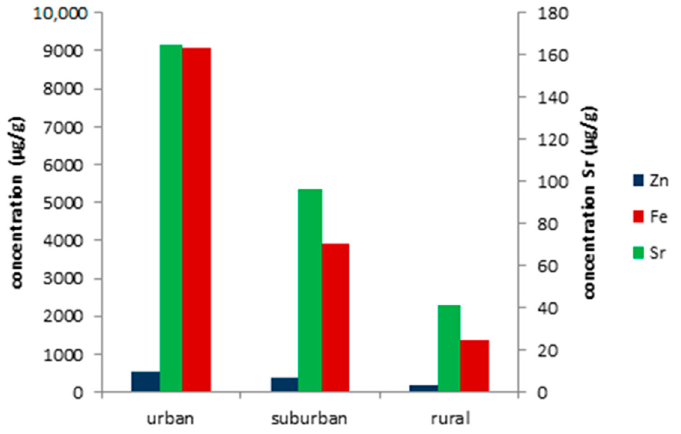
Figure 1. Concentrations of Fe, Zn and Sr in urban, suburban and rural areas. Residences located either on the ground floor or the first floor indicated higher Hg concentrations with respect to those at higher floors (0.62 vs. 0.16 μ g/g, p < 0.05). The age of the house was found to affect the levels of Sr, as higher concentrations in homes older than 20 years (128 vs. 77 μ g/g, p < 0.05) were observed. In houses with a total area of less than 100 m 2 , higher concentrations of Fe (6928 vs. 2526 μ g/g, p < 0.05), Al (2691 vs. 1562 μ g/g, p < 0.05), V (10.6 vs. 5.7 μ g/g, p < 0.05) and Ba (327 vs. 133 μ g/g, p < 0.05) were found. This fact can be related to the lower number of openings (windows and doors) to houses of smaller total area, which consequently leads to lower infiltration rates. Houses that used fireplaces as the main source of heating indicated significantly higher concentrations of Pb (343 vs. 32 μ g/g, p < 0.05), probably due to the burning of painted or treated wood [33,34], while those that were heated using electricity were associated with significantly higher concentrations of Fe (10729 vs. 3529, p < 0.05) and V (12.8 vs. 7.3 μ g/g, p = 0.059), likely due to dust resuspension occurring during the operation of air conditioning. In houses that remained closed (without the presence of occupants) for several hours during the day, higher values of As (8.7 vs. 2.5 μ g/g, p < 0.05) and Sr (152 vs. 93, p < 0.05) were detected in household dust. The type of glazing appeared to affect Pb levels in household dust, as higher concentrations were observed in homes with single glazing compared to those with double glazing (57.8 vs. 46.2, p = 0.078). In terms of glazing on indoor Pb con- centrations, we believe that the effect is not directly related to the type of glazing (or to be more accurate not only related to that) but on the type of the windows used. Double glazed windows are of newer technology and have been found in previous studies to sig- nificantly reduce the infiltration rates [35]. Since Pb is emitted from outdoor anthropo- genic activities and resides in the fine fraction, it is expected that its indoor concentrations will be attributed mainly to infiltration. Finally, as with PAHs, the habit of residents wear- ing shoes inside their dwelling significantly affected the levels of Al (2684 vs. 1850 μ g/g, p = 0.076) and Ba (275 vs. 217 μ g/g, p < 0.05) in house dust. As both elements can be found in urban dust, there are transferred inside the residents by the dust that is found on their shoes. 3.3. Relationship between PAH and Trace Metals Concentrations and Occupant Activities Apart from the household characteristics, the impact of the occupants’ activities on the detection of PAHs and trace metals in dust was also examined.